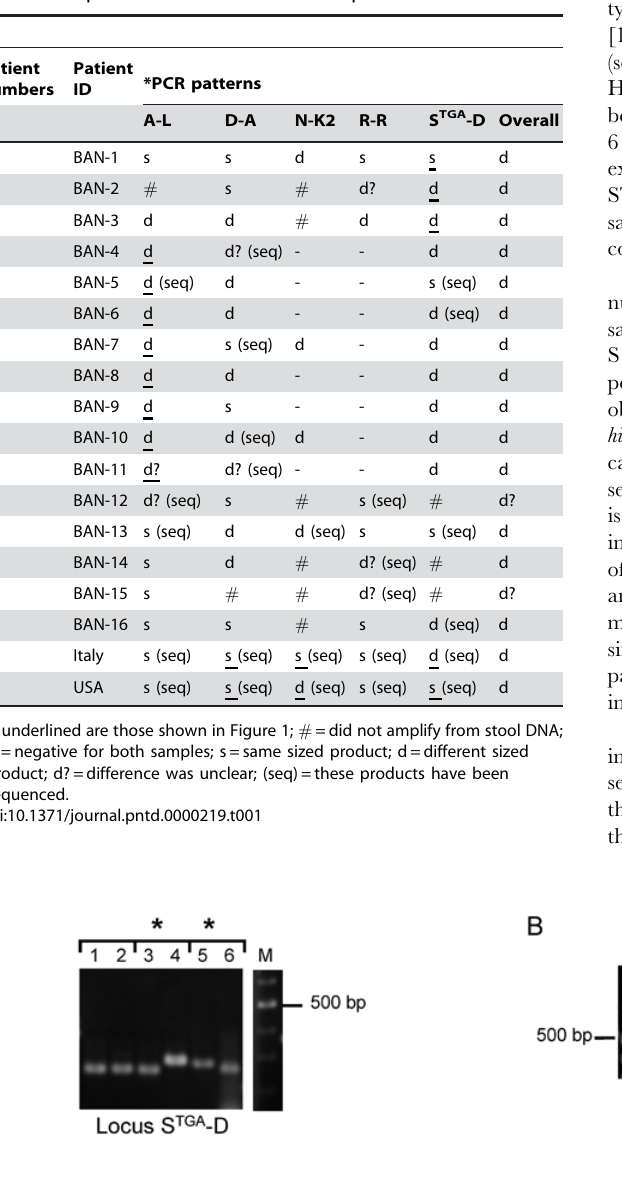
Table 1. PCR patterns with DNA samples from liver abscess and stool specimens of the same ALA